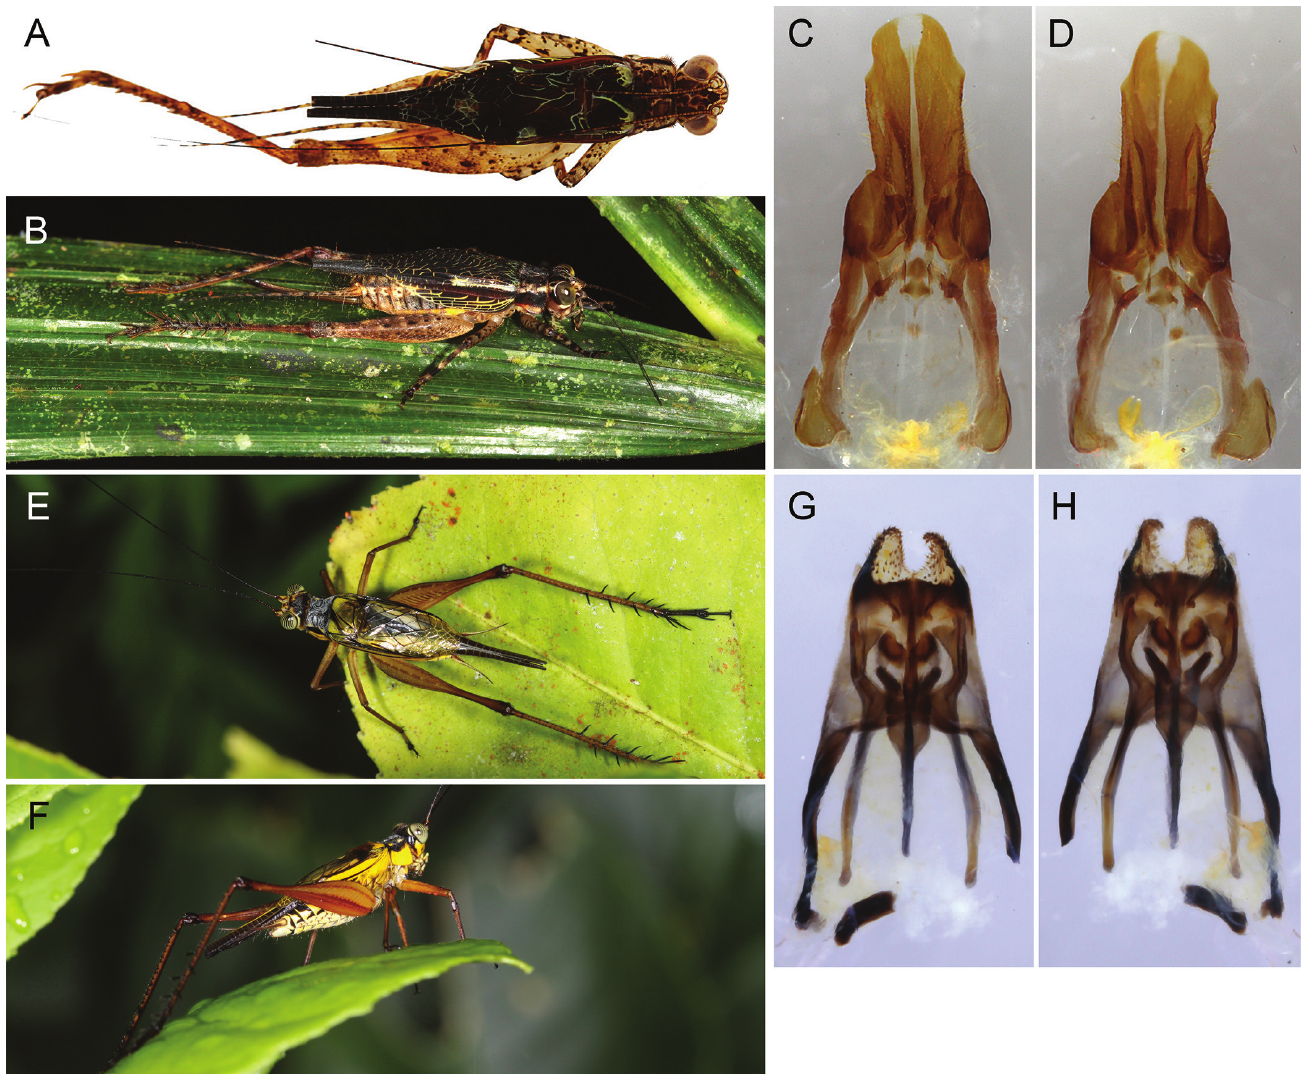
Fig. 8. Gryllidae: Eneopterinae: Cardiodactylus pelagus : A. Male; B. Female; C, D. Male genitalia in ventral and dorsal views respectively; Nisitrus vittatus : E, F. Male; G, H. Male genitalia in dorsal and ventral views respectively.